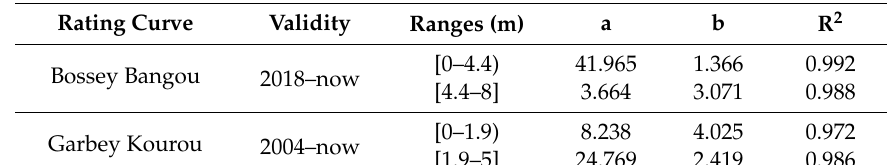
Table 8. Coe ffi cients and application ranges of the rating curves equations of the Bossey Bangou and Garbey Kourou gauging sites.